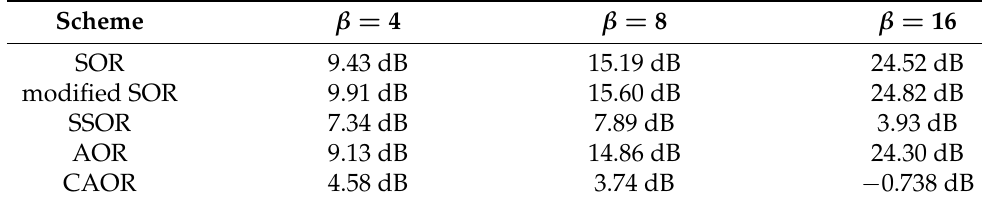
Table 3. Comparison of the degree to which the BER performance approaches that of conventional MMSE among all detectors in terms of dB value under different β as i = 2 and SNR at 40